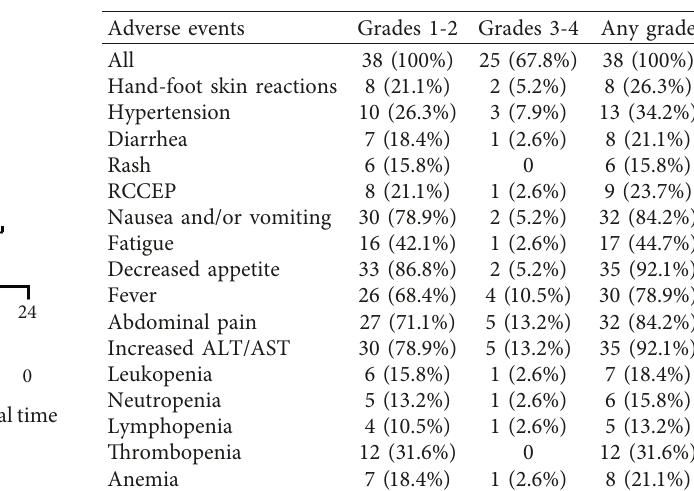
Figure 1: Representative imaging in advanced HCC patients receiving TACE combined with camrelizumab plus apatinib. (a-b) Enhanced abdominal CT showing massive HCC (asterisk). (c-d) Chest CT showing multiple lung metastases (white arrowhead). (e–h) At 3 months after combination therapy, follow-up CTdemonstrated a partial response, with the tumor shrinking significantly in the liver (asterisk) and lung (white arrowhead). Table 3: Adverse events ( n �